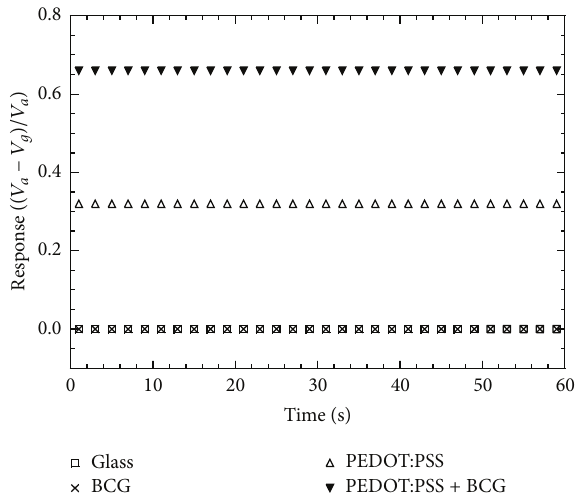
Figure 3: Response profile of ammonia sensor based BCG- PEDOT:PSS-based sensor for different concentrations of ammonia